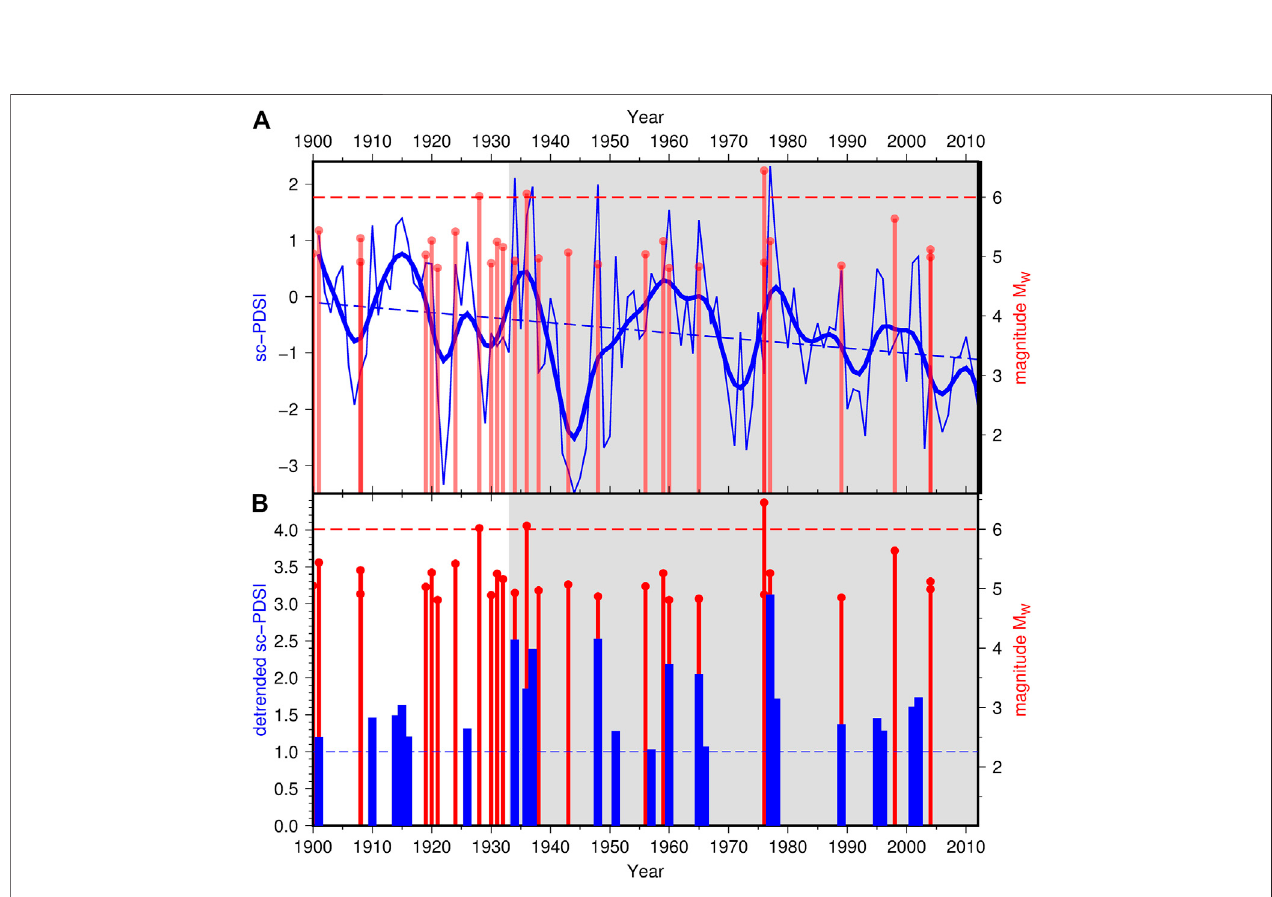
Frontiers in Earth Science |